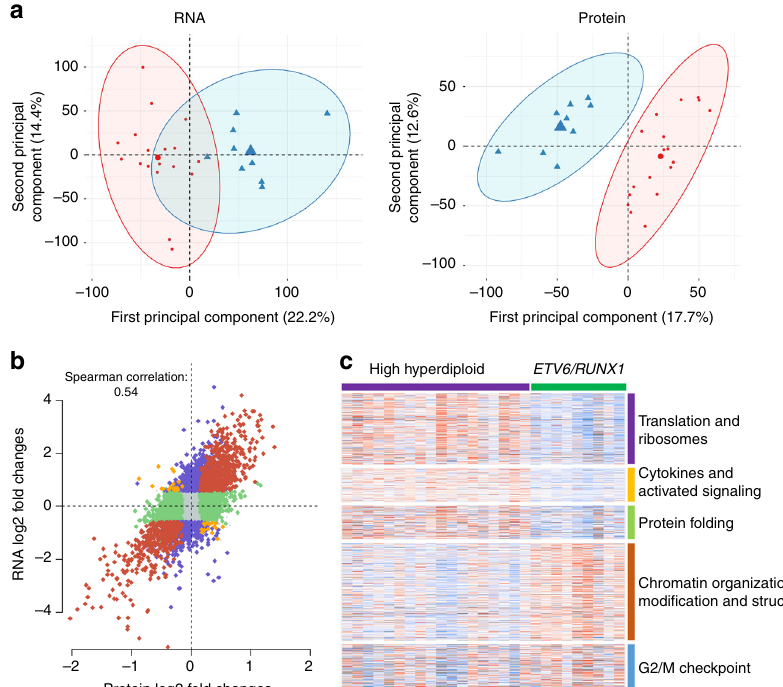
Fig. 3 Clustering and enriched pathways in high hyperdiploid and ETV6 / RUNX1 -positive leukemia. a Principal component analyses of 27 B-cell precursor acute lymphoblastic leukemias showed that high hyperdiploid (red) and ETV6/RUNX1 -positive (blue) cases clustered separately in unsupervised analyses by scaled RNA (left) and protein (right) abundance. b There was a linear relationship between the log2 fold changes of RNA-sequencing and proteomics data (Spearman ’ s correlation coef fi cient = 0.54) between the high hyperdiploid and ETV6 / RUNX1 -positive subtypes, demonstrating a high correlation between changes on the transcript and translation levels of an individual gene product. The correlation was stronger for gene/protein pairs with high fold changes. Signi fi cant changes found in both RNA-seq and LC-MS/MS are shown in red, inverse changes found in RNA-seq and LC-MS/MS in yellow, signi fi cant changes found only in LC-MS/MS in green, and changes only found in RNA-seq in purple. c Gene set enrichment analysis of protein data highlighted sets of pathways that were signi fi cantly different between high hyperdiploid and ETV6/RUNX1 -positive